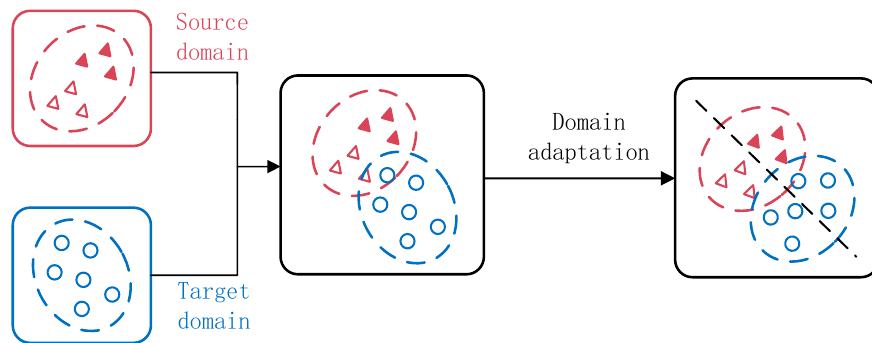
Figure 1. Schematic diagram of mechanical fault diagnosis based on transfer learning.